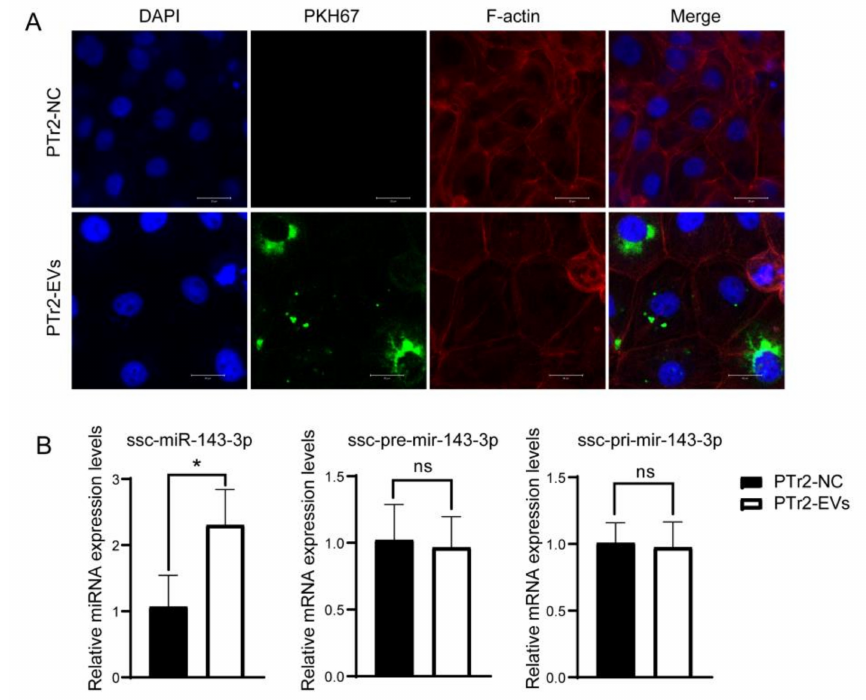
Figure 3. Ssc-miR-143-3p derived from extracellular vesicles in uterine luminal fluid (ULF-EVs) targeted transport to porcine trophoblast cells (PTr2 cells). ( A ) Internalization of ULF-EVs by PTr2 cells was observed by confocal microscopy. DAPI: Cytosolic dyes, PKH67: EVs dyes, F-actin: Cell membrane actin. Scale bars = 20 µ m. ( B ) RT-qPCR detected significant upregulation of ssc-miR-143-3p expression in PTr2 cells after co-incubation with EVs. Negative control (NC), add an equal volume of PBS. * p < 0.05; ns—not